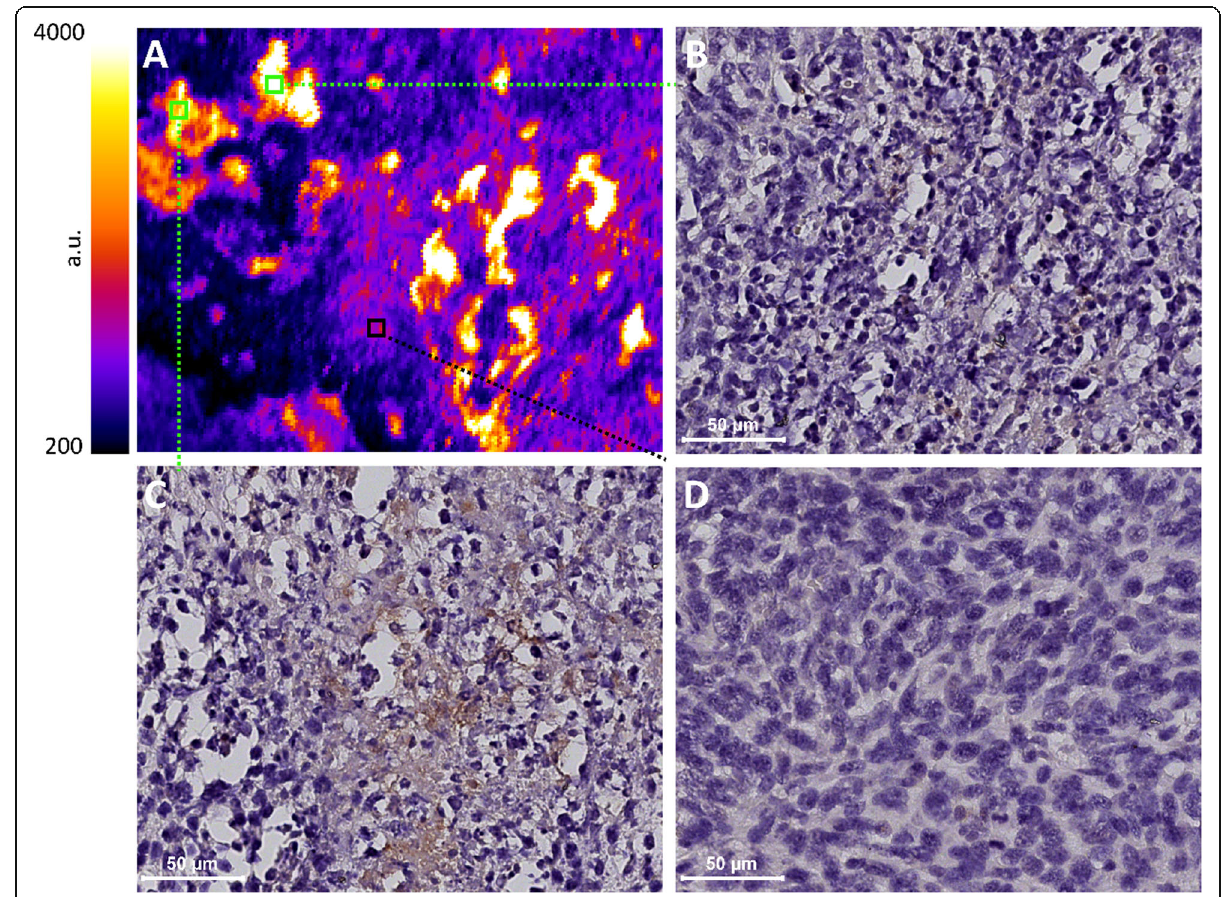
Fig. 4 Microscopic fluorescent signal of VGT-309 colocalizes with tumor-infiltrated immune cells including macrophages. a A representative fluorescent image of a 4- μ m-thick tumor slide from the mouse imaged 24 h after intravenous injection of VGT-309. Corresponding F4/80 immunohistochemical staining images of the areas highlighted by squares in a show b immune infiltrate containing few macrophages, c a high presence of macrophages, and d tumor